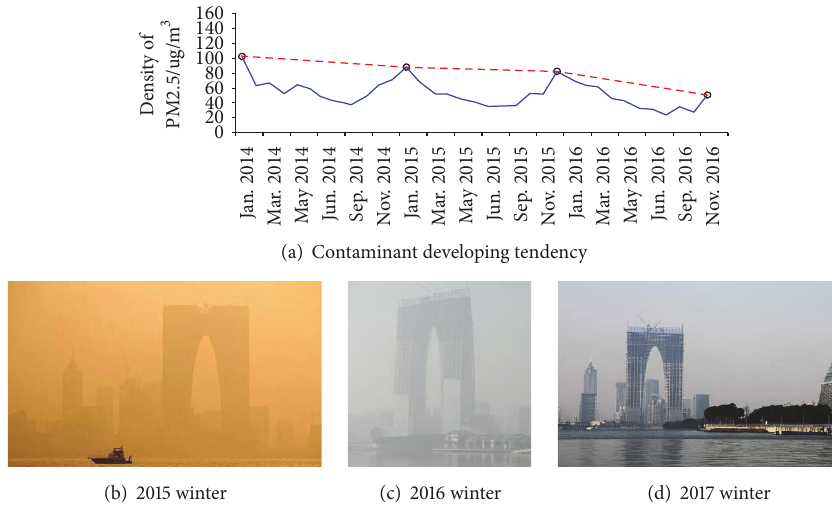
Figure 9: Comparison of the smog reduction around the Gate of the